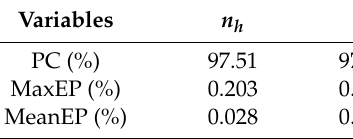
( d ) Figure 12. Dynamical behaviors ( a ) 𝑛 (cid:3035) , ( b ) 𝑛 (cid:3039) , ( c ) 𝑇 (cid:2871)(cid:2873) ∗ and ( d ) 𝑝 (cid:2872) ∗ of the CEME model and the NCL model.